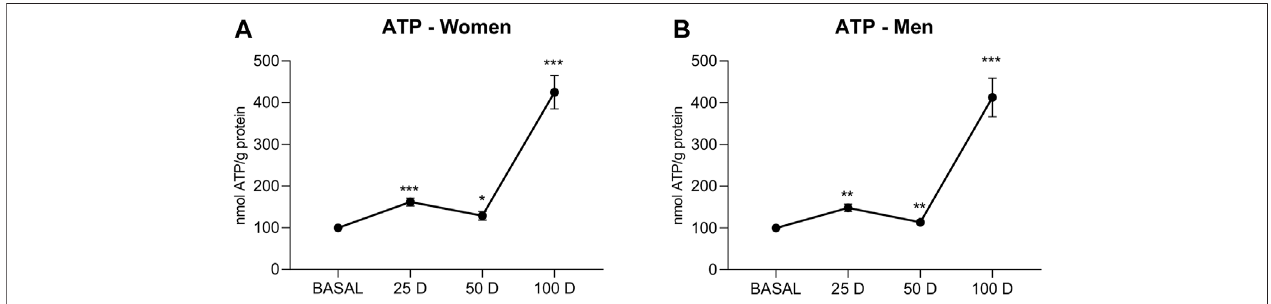
FIGURE 6 | ATP content (expressed as nmol ATP/g protein) of lymphocytes extracted from women (A) and men (B) at baseline (BASAL), 25 days (25 D), 50 days (50 D) and 100 days (100 D). Data are mean ± SEM. *BASAL vs.25, 50 and 100 D. The number of symbols marks the level of signi fi cance: one for p < 0.05, two for p < 0.01 and three for p <